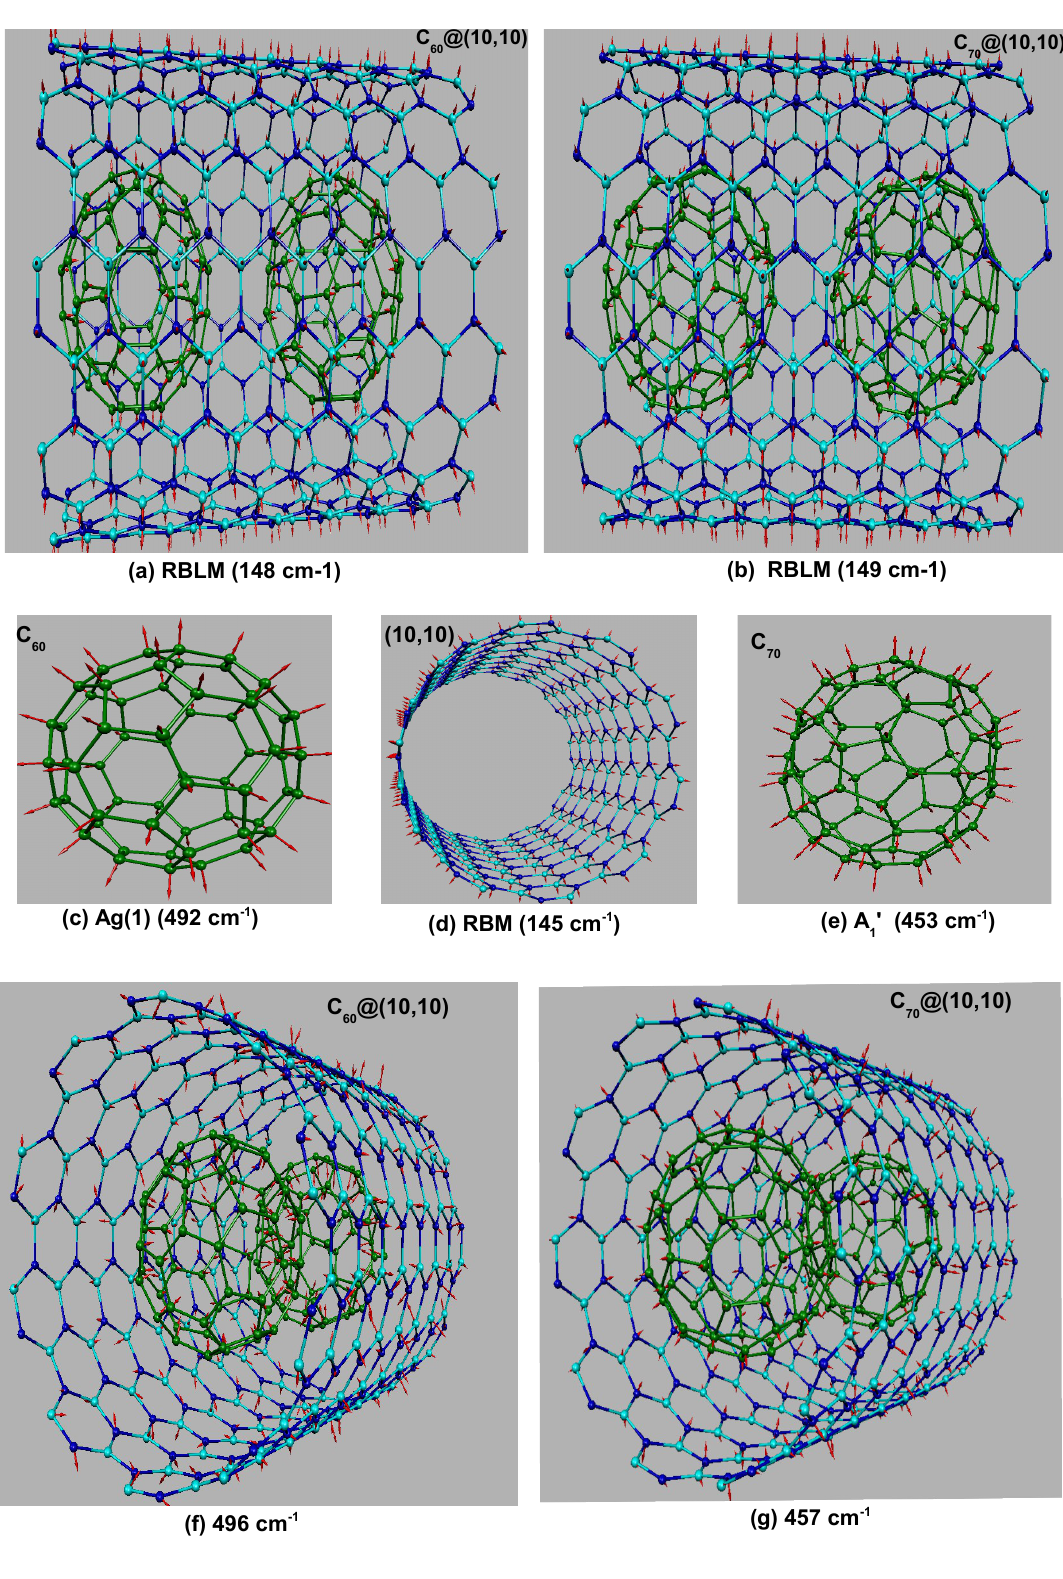
Figure 3. Calculated atomic motions (eigendisplacement vectors) in C 60 , C 70 , (10,10) SWBNNT, C 60 @(10,10) and C 70 @(10,10). Arrows are proportional to the amplitude of the atomic